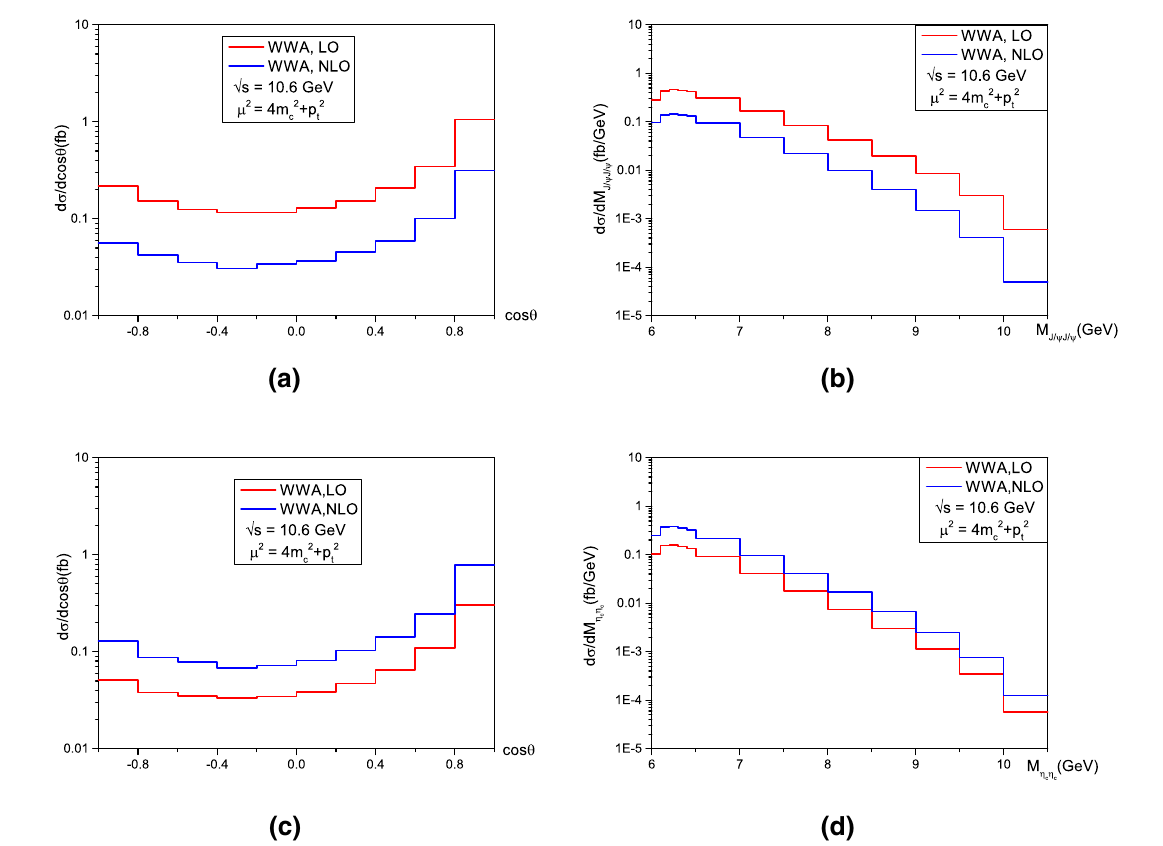
(cid:15) 4 m 2 c + p 2 t . The